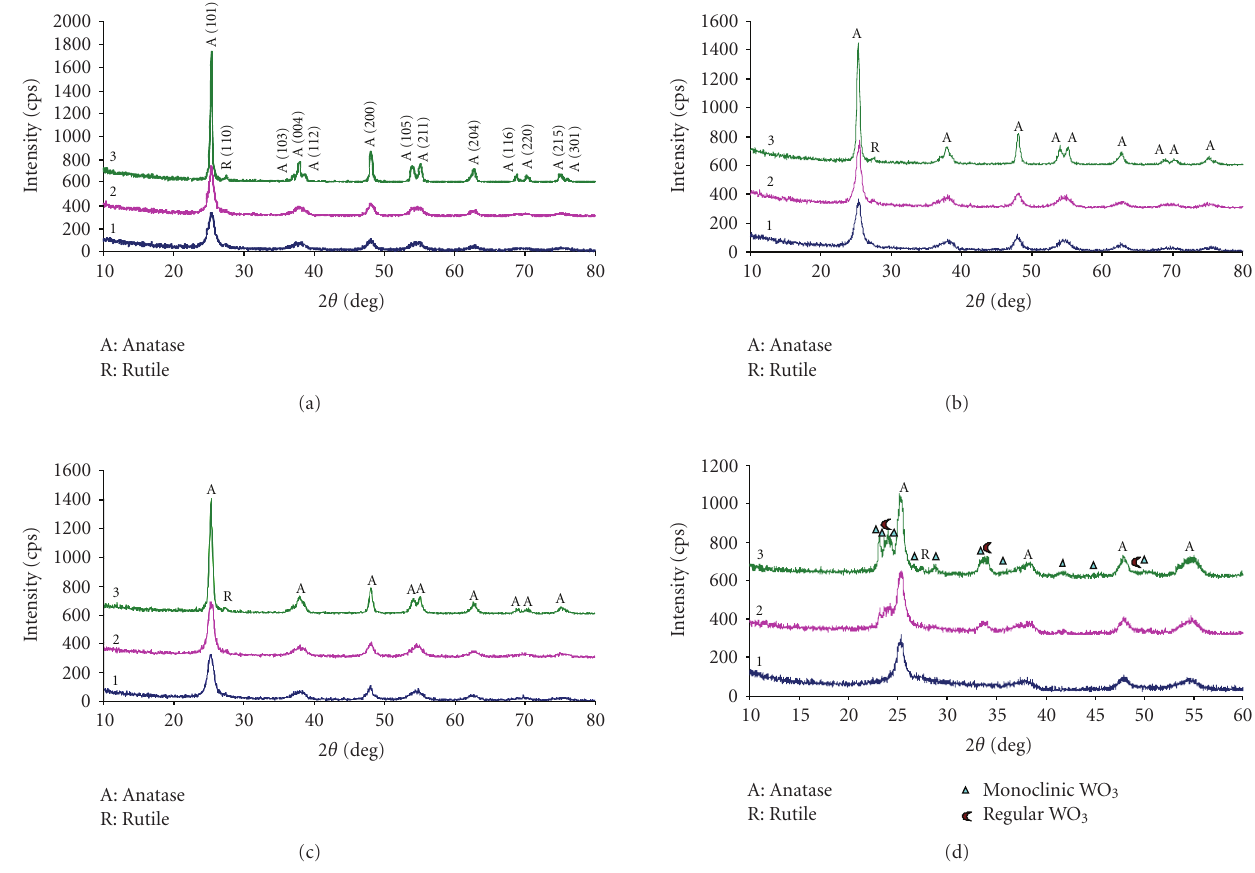
Figure 2: XRD patterns of (a) TiO 2 , (b) TiO 2 -WO 3 -3%, (c) TiO 2 -WO 3 -10%, and (d) TiO 2 -WO 3 -90% photocatalysts: (1) as received, (2) 400 ◦ C-treated, (3) 600 ◦